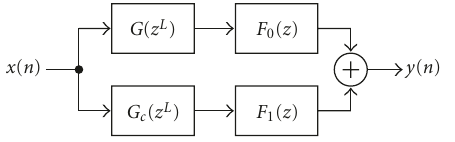
Figure 2: Structure used in the FRM approach.